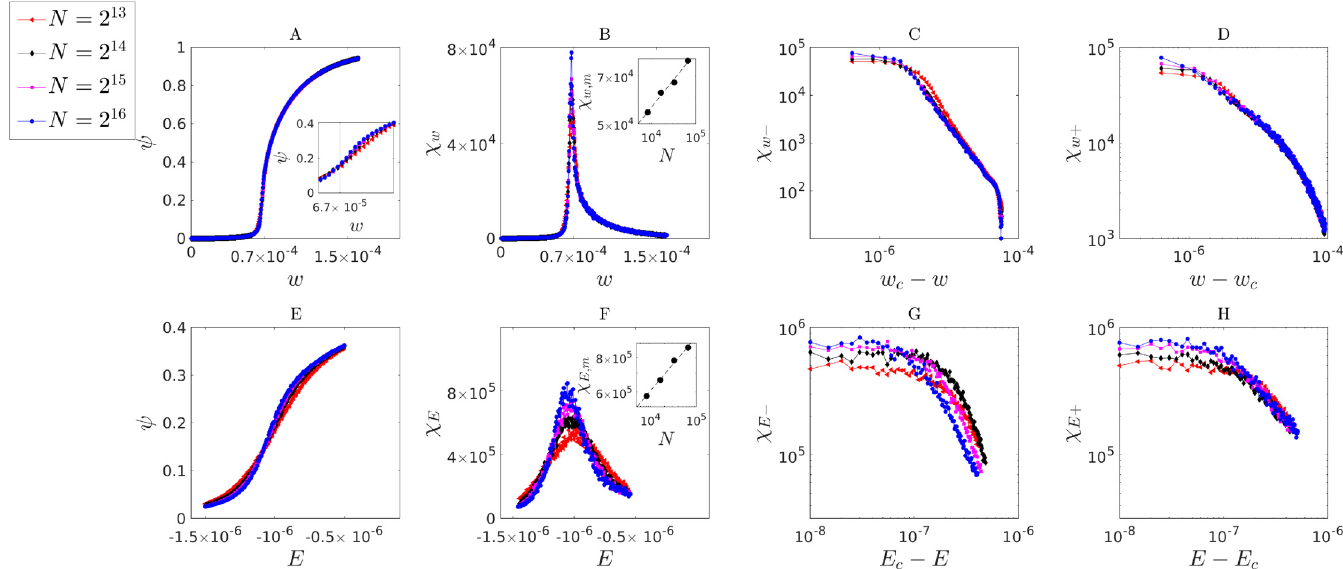
Fig 10. Power-law divergence of response functions w ¼ @ c and w ¼ @ c near the critical point. We used finite-size scaling analysis over four different network sizes of w E @ w @ E 2 13 , 2 14 , 2 15 , 2 16 . A The expected value of the normalized spread size, ψ = h s / N i , as a function of w (fixed E ) near the critical point ( w c � 6.76 10 − 5 , E c � 1.00 10 − 6 ). The inset zooms the view around the critical point. B The response χ w plotted as a function of w (for fixed E = E c ). The inset shows the divergence of the maximum response χ w , m as a function of χ w , m * N 0.16(1) . C,D The log-scale plots show the power-law behavior of the response function χ w as w approaches the critical point from below with corresponding scaling χ * ( w ) β 0 − 1 and exponent estimated as ^ b 0 ¼ (cid:0) 0 : 96 ð 3 Þ , and from above with corresponding scaling χ * ( w − w ) β − 1 and exponent w − c − w w + c estimated as ^ b ¼ 0 : 43 ð 5 Þ . E The expected value of the normalized spread size, as a function of E near the critical point (for fixed w = w c ). F The response χ E plotted as a function of E (for fixed w = w ). The inset shows the divergence of the maximum response χ as a function of χ * N 0.18(1) . G,H The log-scale plots show the power- c w , m w , m law behavior of the response χ as E approaches the critical point from below with corresponding scaling χ * ( E ) 1/ δ 0 − 1 and exponent estimated as ^ d 0 ¼ (cid:0) 1 : 6 ð 5 Þ , E E − c − E and from above with corresponding scaling χ E + * ( E − E c ) 1/ δ − 1 and exponent estimated as ^ d ¼ 12 ð 5 Þ